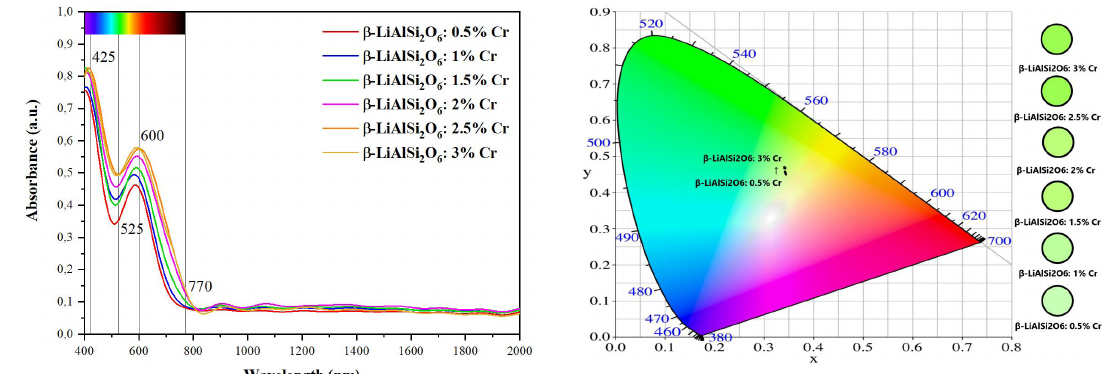
Figure 5. CIE-XYZ (1931) diagram chromatic coordinates of O :Cr samples. β-LiAlSi O :Cr samples. The coordinates were generated from the 2 6 2 6 radiance emitted by the halogen light used by the vis-NIR DRS, and there may be variations in the pigment color perception depending on the local